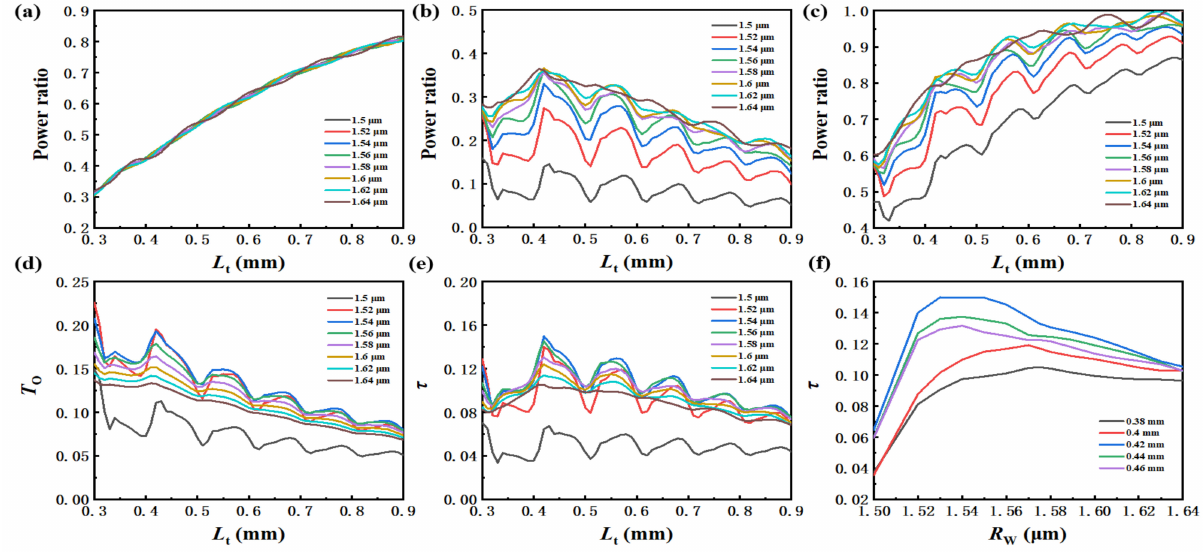
Figure 6. Calculated ( a ) fundamental mode proportion; ( b ) LP 11 -like mode proportion; ( c ) light transmittance; ( d ) evanescent proportion; ( e ) evanescent efficiency with different L t as R w changes from 1.5 to 1.61 µ m; ( f ) calculated evanescent efficiency with different R w as L t changes from 0.38 to 0.46